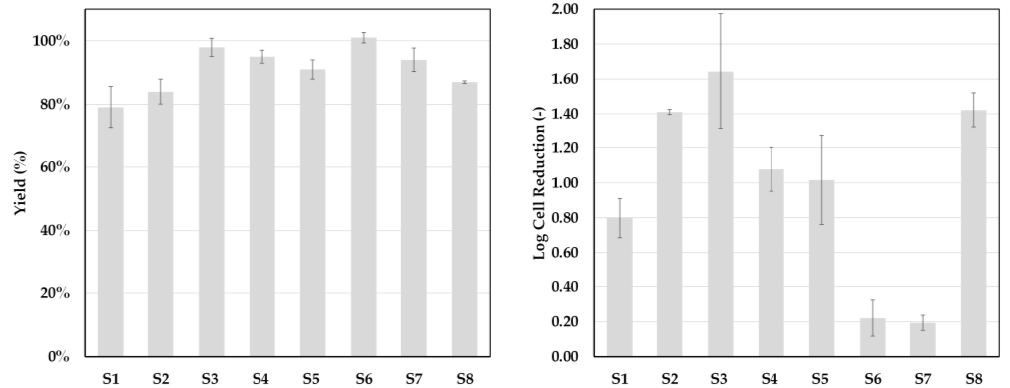
Figure 11. Yield and cell clearance for eight continuous settling experiments (S1–S8).